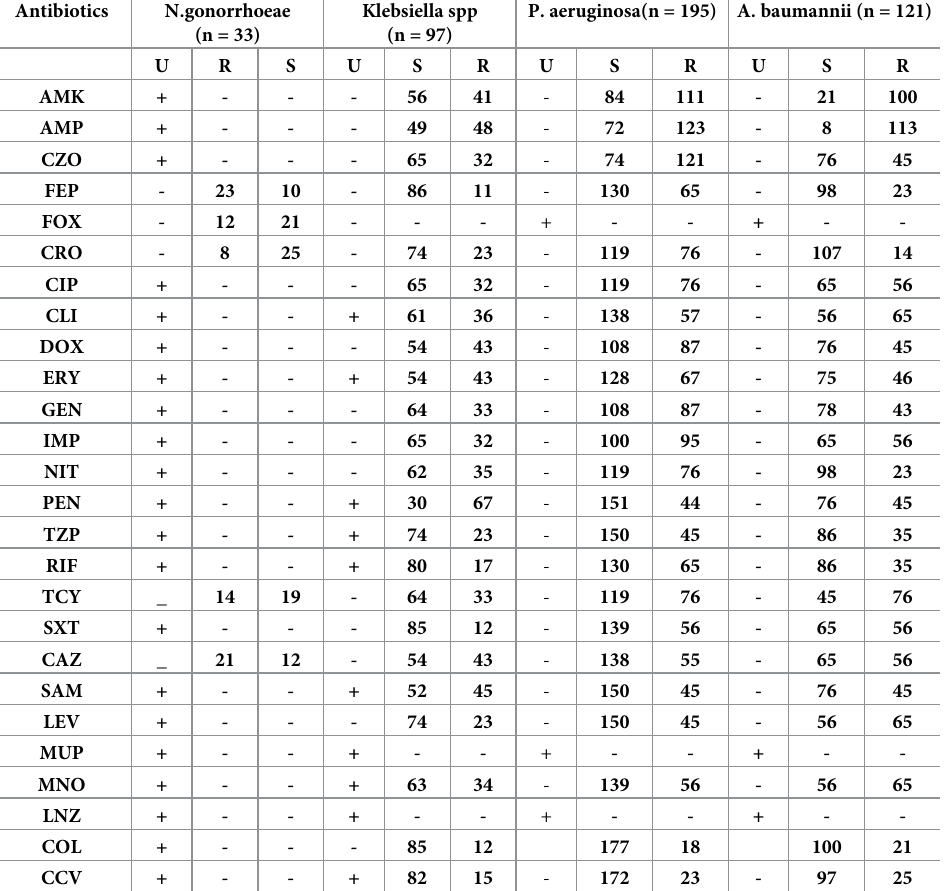
Table 3. Antibiotic resistance pattern for Gram-negative bacteria.